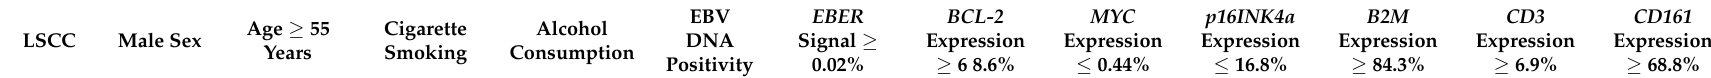
Table 4. Spearman’s correlations between clinical characteristics, laryngeal EBV-related biomarkers, and laryngeal histological characteristics in the overall cohort. Characteristics